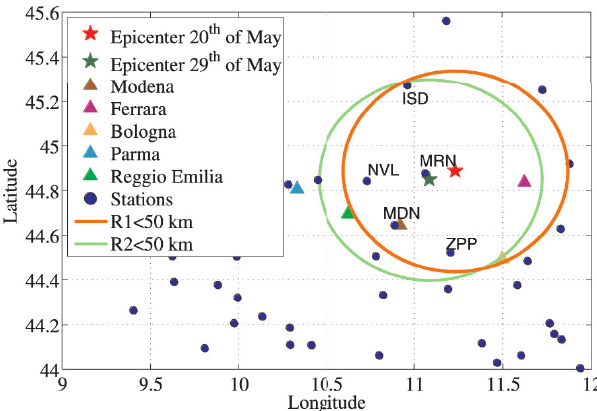
Figure 1. RAN recording stations within ca. 200 km of the epicenters, and those considered within 50 km.